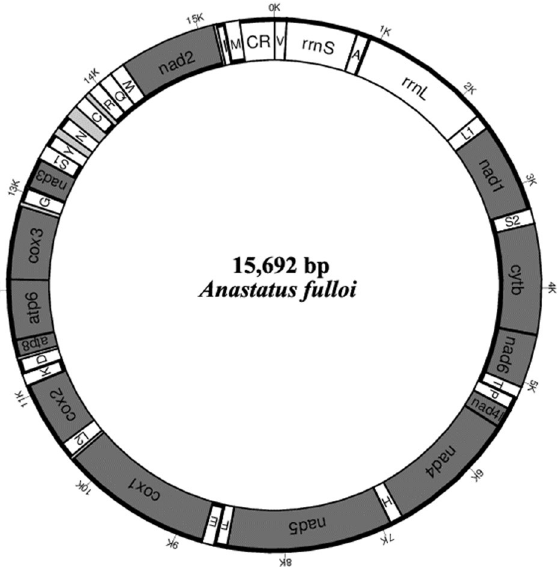
Figure 1. Mitochondrial map of Anastatus fulloi . PCGs are marked in grey. Genes marked with bold lines outside the circle map are encoded on the heavy strand.